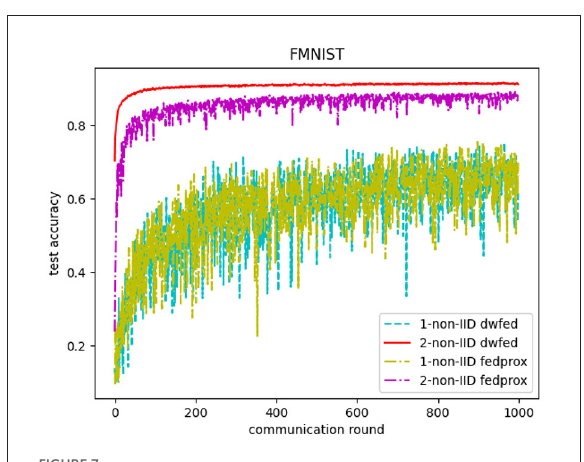
FIGURE7 Test accuracy of FedProx and DWFed on